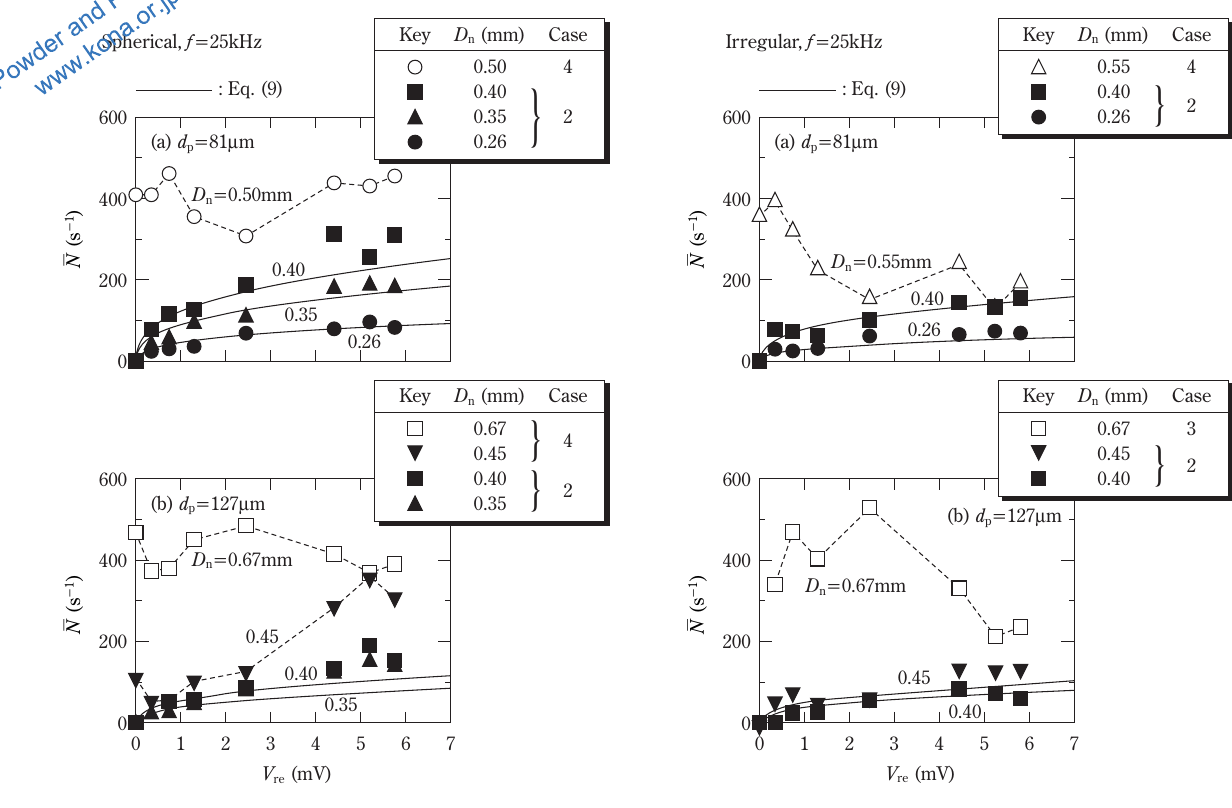
Fig. 8 Average discharge rate of spherical particles, N (cid:3) , under var- ious operating conditions